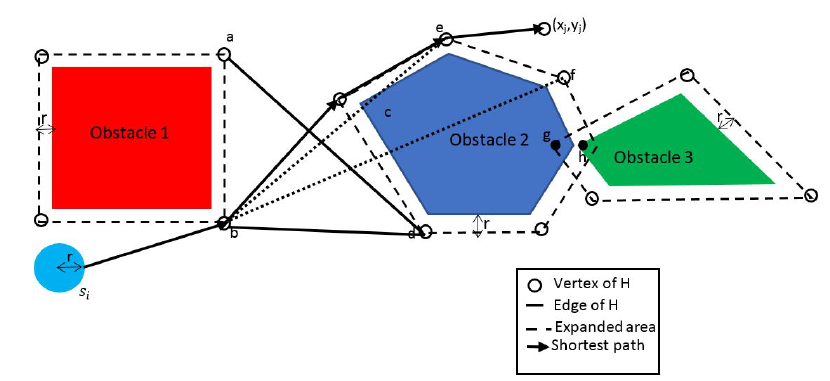
Figure 19. Finding a collision free path in